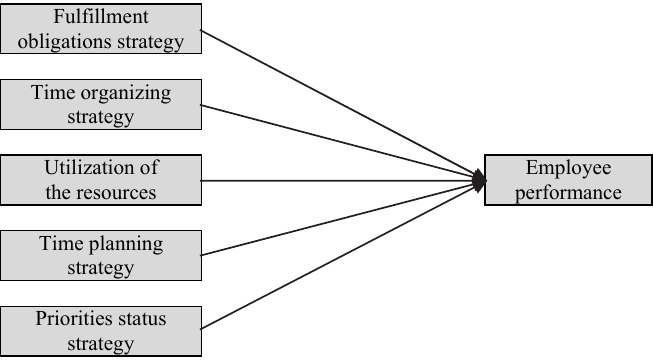
Fig. 1. The proposed study (Tracy,